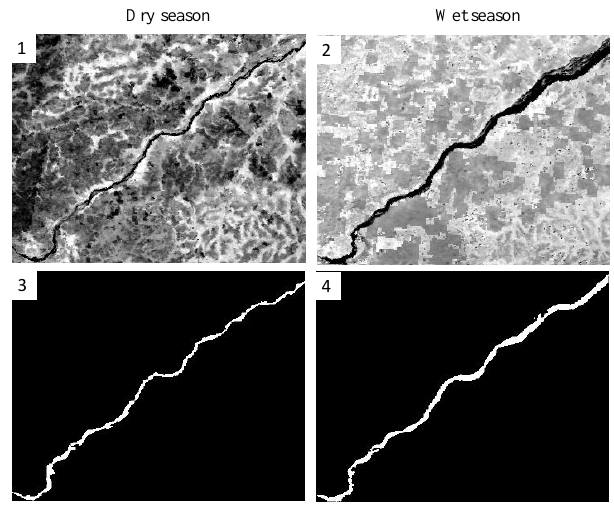
Figure 19. ( 1 , 2 ) are two examples of the river section (Niger River, Koulikoro Station) in dry and wet seasons. ( 3 , 4 ) are the water mask determined by the proposed method.